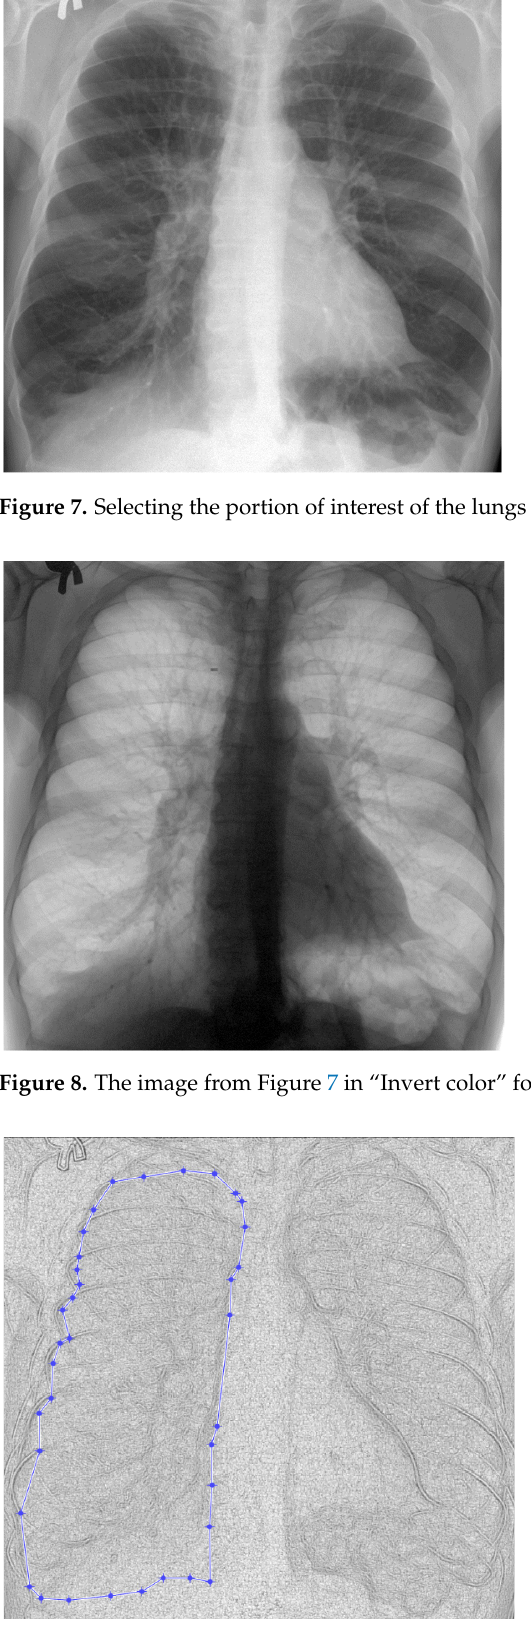
Figure 10. De fi ning the mask for the right lung of the second patient. Table 2 shows the known fractal indicators, such as the fractal dimension of the CT image of the left lung, d 1L = 1.9286 ± 0.2480, and the lacunarity Λ = 0.0165; and the fractal dimension of the right lung, d 1R = 1.9263 ± 0.2624, and the lacunarity, Λ = 0.0185. Table 2. Fractal indicators for the second patient . 2. EF Date 22 December 2022